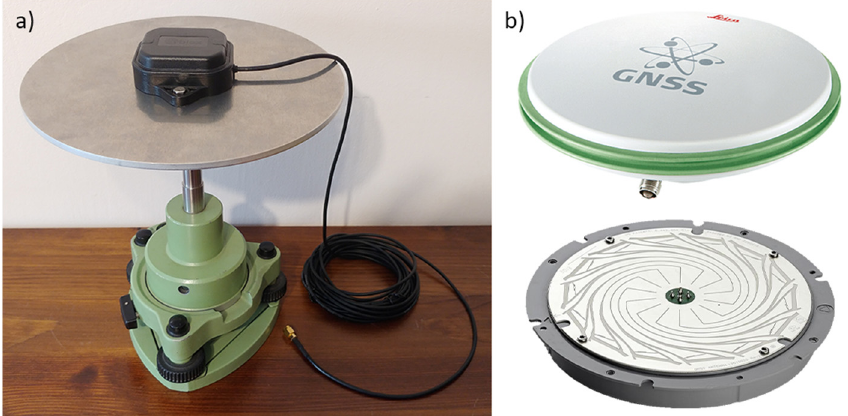
Figure 1. Antennas used in conducted experiment: ( a ) u-blox ANN-MB-00 antenna with self-made aluminum ground plane; ( b ) survey-grade antenna Leica AS10 outside and inside (NovAtel Pinwheel technology) view.